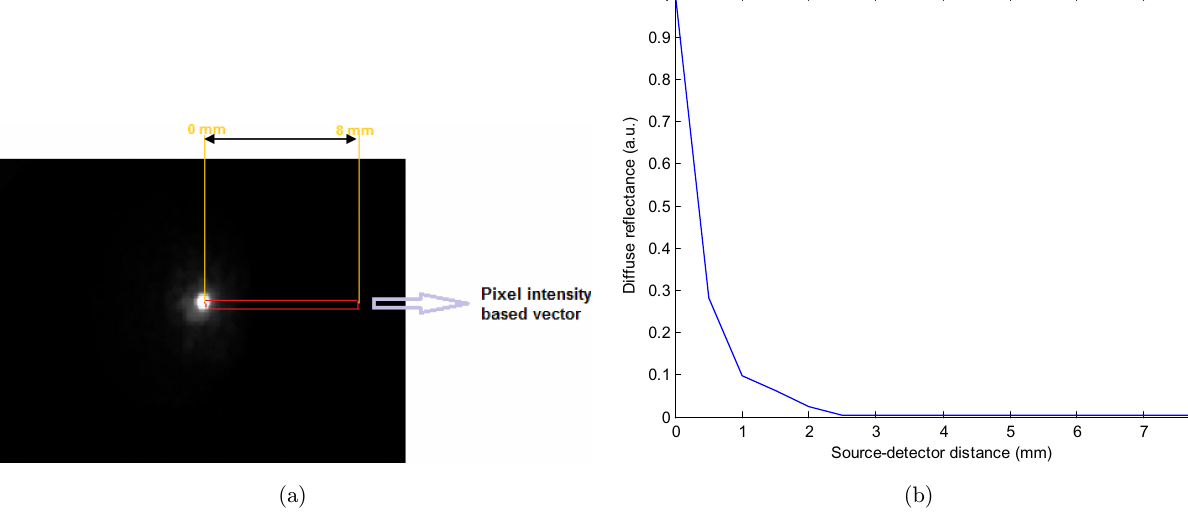
Fig. 5. The related image and corresponding re°ectance spectrum for (cid:1) s ¼ 1.4289 cm (cid:2) 1 , (cid:1) a ¼ 8.8373 cm (cid:2) 1 . (a) 6th phantom in Table 1 after applying image processing. (b) Spatially resolved di®use re°ectance versus distance for